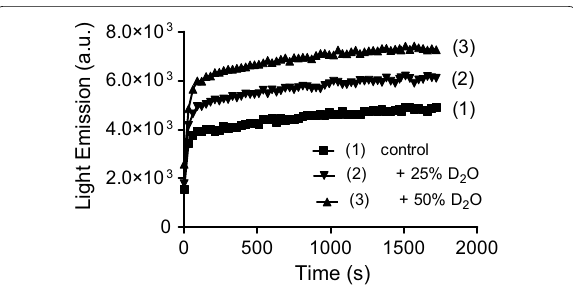
Fig. 3 Effect of deuterium oxide in the light emission. Control reac- tion: NCT 1 mM, melatonin 1 mM, H 2 O 2 3 mM in 0.1 M glycine buffer pH 9.0 and 37 °C. One representative experiment of 3 independent ones with similar outcome is